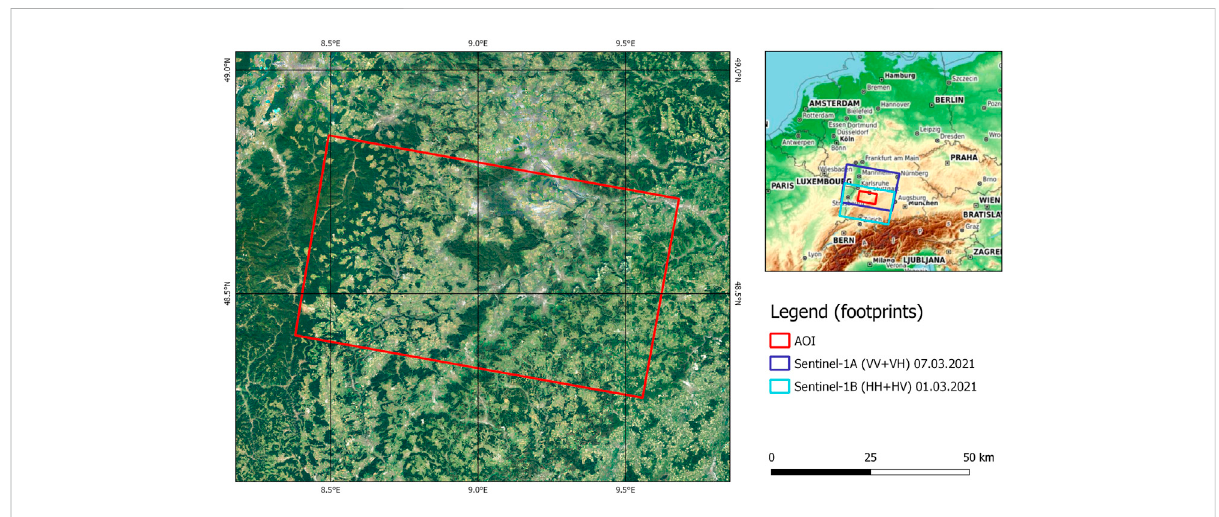
FIGURE 1 Location of the study area (AOI) and extent of the satellite image products. Base map © European Union, contains modi fi ed Copernicus data [2022], processed by Bundesamt für Kartographie und Geodäsie